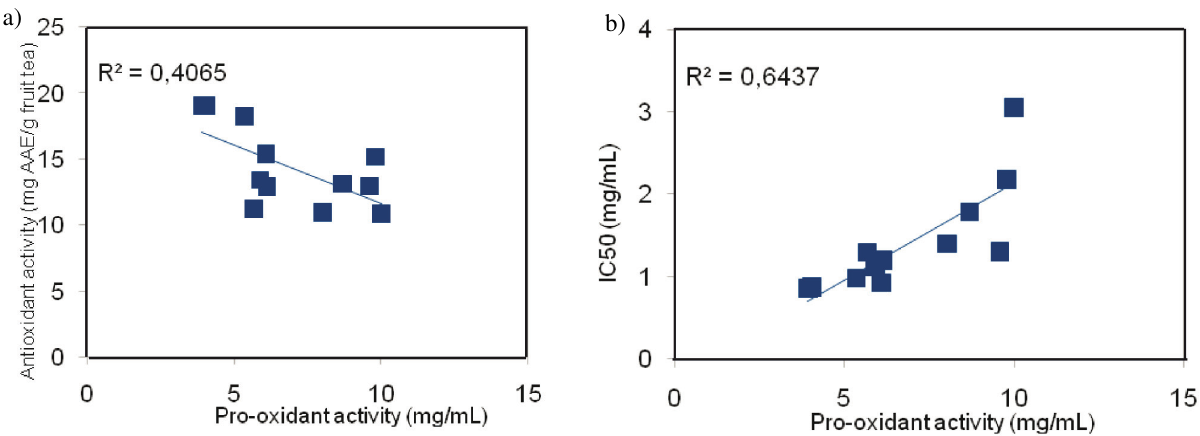
Figure 1. The correlation between Pro-oxidant activity and antioxidant activity ( a ), respectively Pro-oxidant activity and IC50 ( b